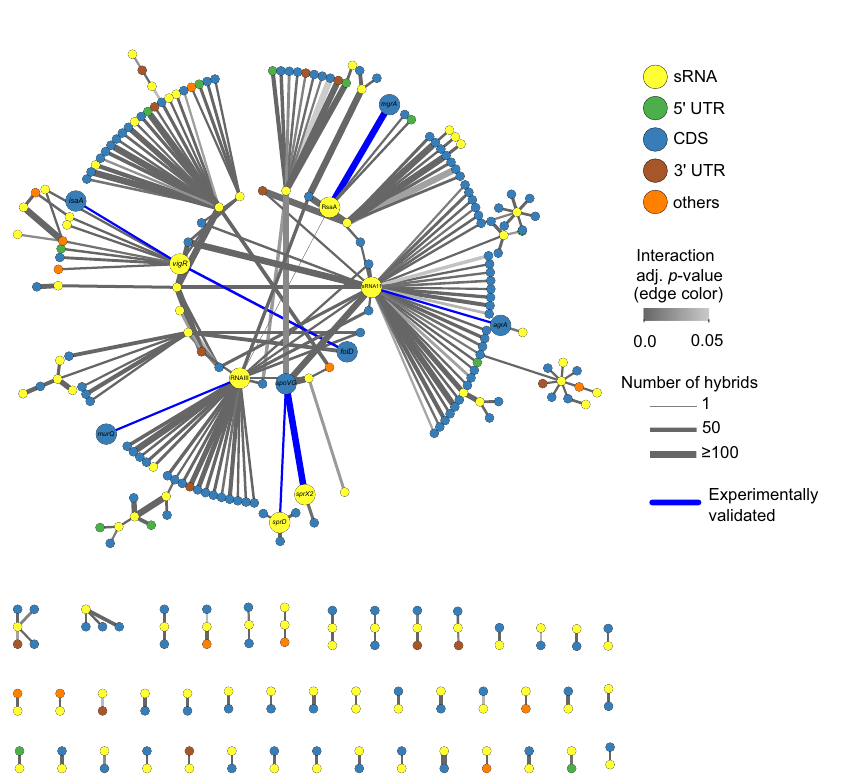
Fig. 2 RNase III-CLASH recovers RNA – RNA interactions in S. aureus JKD6009. a Histogram of the RNA classes recovered by RNase III-CLASH expressed as the number of hybrid reads ( left ) and number of unique RNA – RNA interactions (multiple hybrid reads can represent one RNA – RNA interaction) ( right ). b Distribution of the number of hybrid reads representing each RNA – RNA interaction recovered by RNase III-CLASH. Each RNA – RNA interaction type is indicated below and the number of independent experiments containing the interaction is indicated by the size of the data point. c Cumulative count of RNA – RNA interactions at start codons (indicated by the red dashed line). d Cumulative distribution function of RNA – RNA interaction strength ( Δ G , kcal/mol) for all RNA – RNA interactions recovered ( left ), or ncRNA – RNA interactions ( right ). Pairs of interacting RNAs were randomly shuf fl ed and the distribution of interaction strength of randomly paired RNAs is shown in red. A two-sided Kolmogorov – Smirnov test was used to calculate p- values. e – h RNA – RNA interactions recovered by RNase III-CLASH are functional. Constitutively transcribed GFP translational fusions to SpoVG ( e ) and MgrA ( f ) were expressed in S. aureus RN4220 with or without transcription of cognate sRNAs (indicated below) and median fl uorescence intensity (MFI) measured using fl ow cytometry. Histogram heights represent mean MFI and error bars represent the standard deviation (SD) from n = 3 biological replicates. Signi fi cance was calculated using a two-sided t- test. * p < 0.05. Predicted interactions between RNAs recovered in hybrid reads are indicated ( right ). Blue boxes indicate the ribosomal binding site and start codon for each mRNA. f Compensatory point mutations (M1) were introduced into mgrA and RsaA (indicated by arrows). MFI was measured for combinations of mgrA and RsaA M1 mutants (indicated below histogram). For interactions within the CDS, qRT-PCR was used to quantify target mRNA abundance (relative to gapA ) in S. aureus RN4220 constitutively transcribing the sRNAs sRNA11 ( g ) or RNAIII ( h ) from the vector pICS3 (indicated below plot). The mRNAs agrA ( g ) and murQ ( h ) are expressed from the chromosomal loci. Histogram heights represent mean relative abundance and error bars indicate standard error from n = 3 biological replicates. p- values were calculated using a two- sided t- test. Predicted interactions between RNAs recovered in hybrid reads are indicated ( right ).